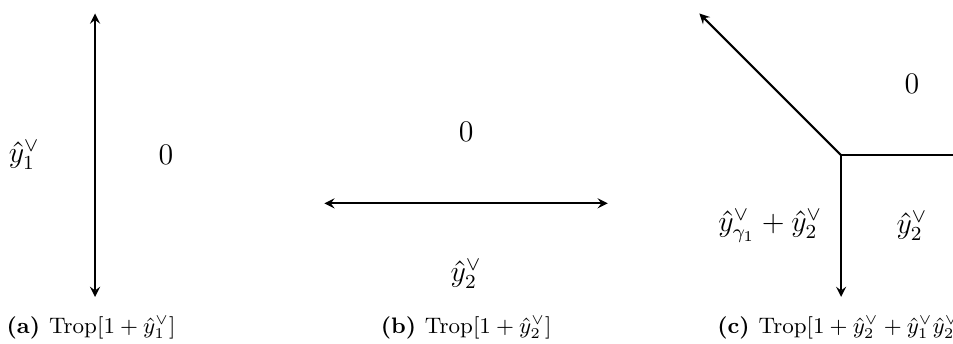
Figure 11. The fan associated with the tropicalization of functions in eq. (4.5).